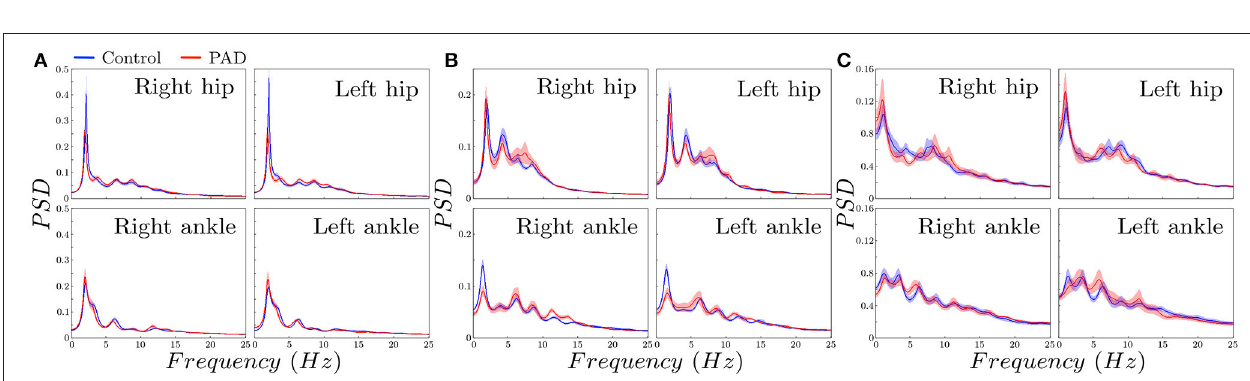
FIGURE 4 | Results represented as mean ± std. In each graph, the symbol * indicates that the p -value < 0.05. Tow-tailed test. (A) Fundamental frequency, (B) Dominant frequency, and (C) Regularity index.